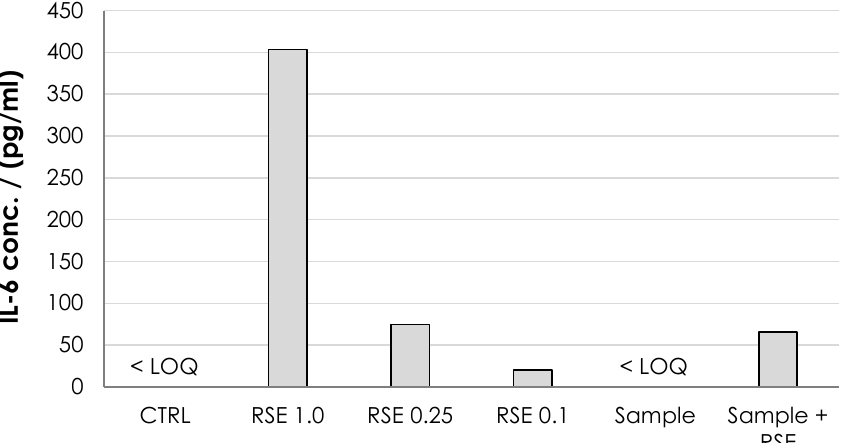
Figure 11. Monocyte activation expressed as the IL-6 concentration. The negative control (normal saline, CTRL) and tested dressing solution (sample) were below detection limit for IL-6 ELISA (<LOQ; 2 pg/mL). Three solutions of endotoxin standards (RSE) were used as positive controls at 1.0, 0.25 and 0.1 EU/mL. The standard addition of RSE at 0.25 EU/mL to the sample was used to assess the potential inhibition of MAT by the sample.